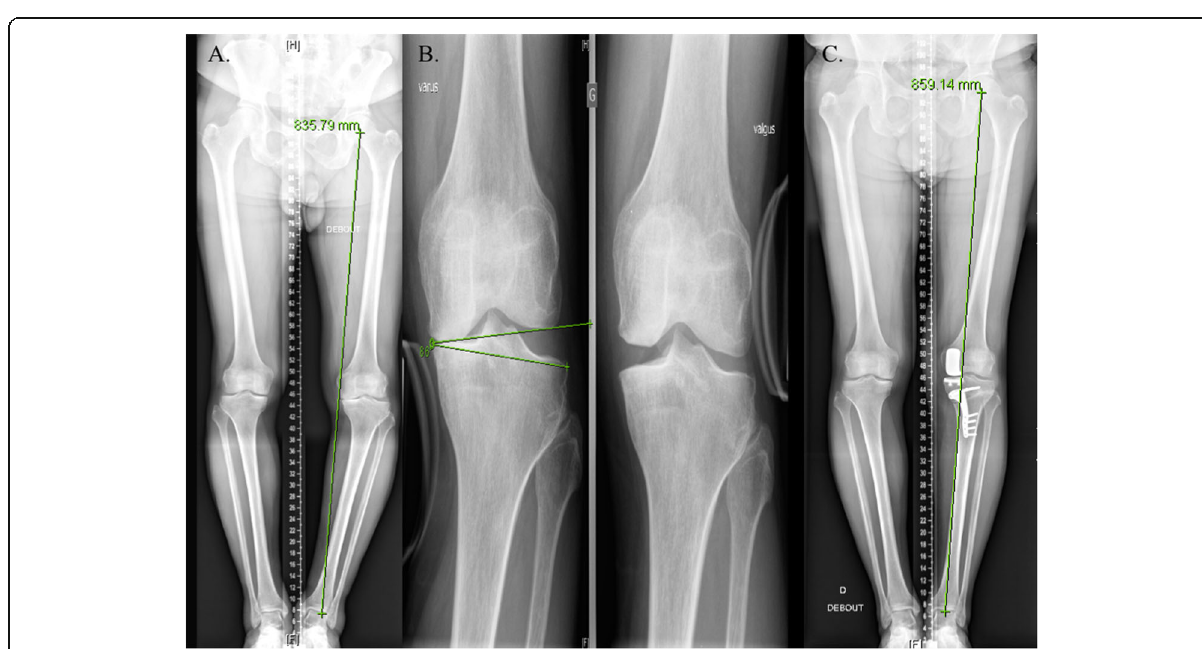
Fig. 3 Lower limb varus alignment due to bony and intra-articular deformities. a . Patient with a preoperative varus alignment of 14° essentially due to a tibial varus (MTPA = 80°), b . The preoperative JLCA measured under varus stress was excessive (JLCA = 17°) suggesting a major postoperative risk of overcorrection c . the patient had a an unicompartmental knee prosthesis performed first and simultaneously to his osteotomy allowing to correct the intra-articular and tibial deformities (postoperative MPTA = 86°), the postoperative lower limb morphotype was neutral (HKA angle =